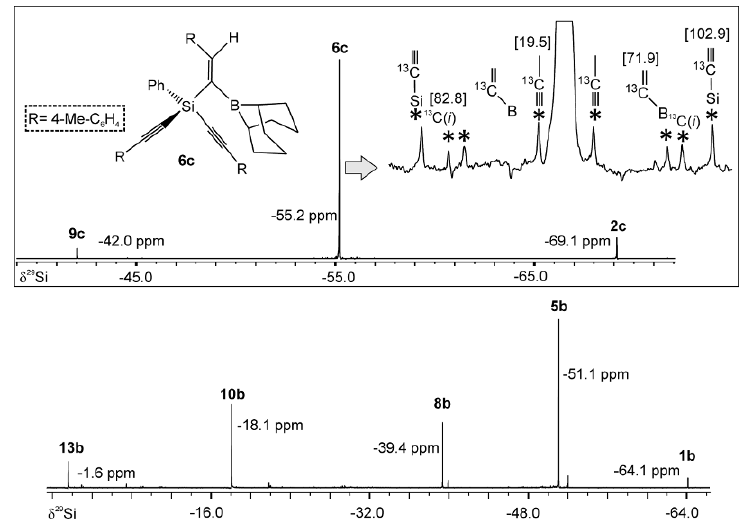
Figure 1. 29 Si{ 1 H} NMR spectra of a mixture of compounds 1b , 5b, 8b , 10b and 13b (lower trace). The upper trace shows quantitative formation of 6c and trace amount (ca. 5 %) of 9c . 13 C satellites are marked by asterisks in expansion ( 6c ) for 1 J ( 29 Si, 13 C) and 2 J ( 29 Si, 13 C). Values against each signal (ppm) and in square brackets represent 29 Si chemical shift and coupling constants, respectively.